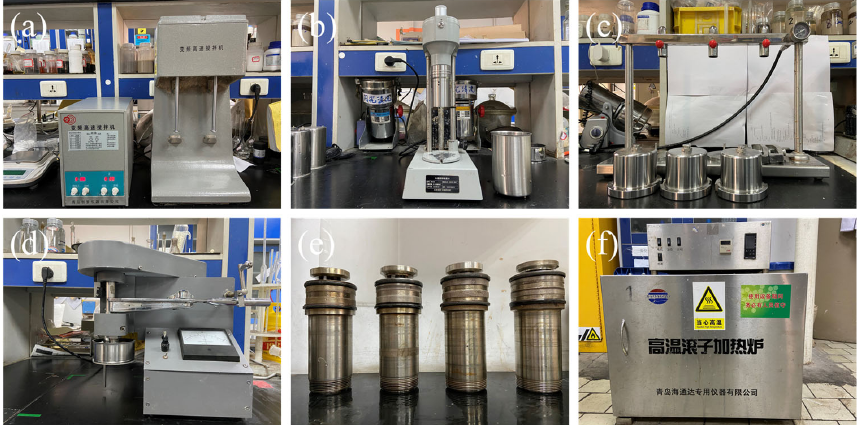
Figure 12. Instruments used during the experiment. ( a ) High ‐ speed mixer; ( b ) Six ‐ speed rotational viscometer; ( c ) Medium ‐ pressure filter press; ( d ) Extreme pressure and lubricity tester; ( e ) High ‐ temperature aging tank; ( f ) High ‐ temperature hot ‐ rolling furnace.